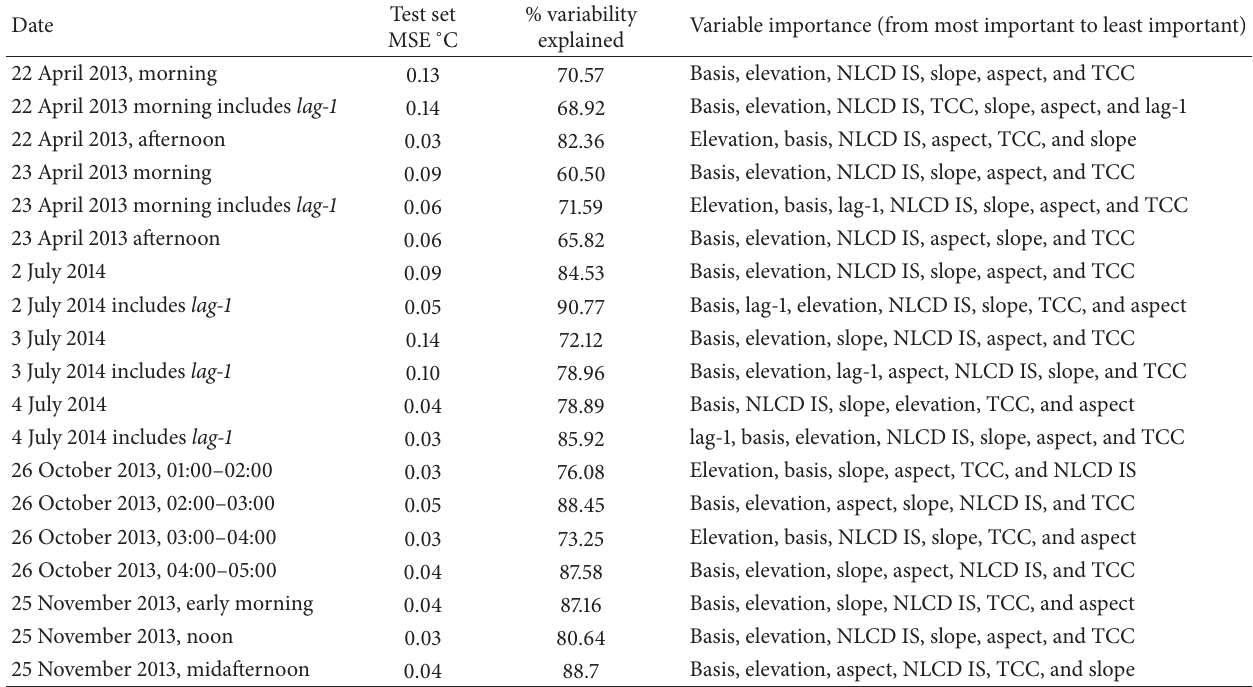
Table 4: Random Forest fit